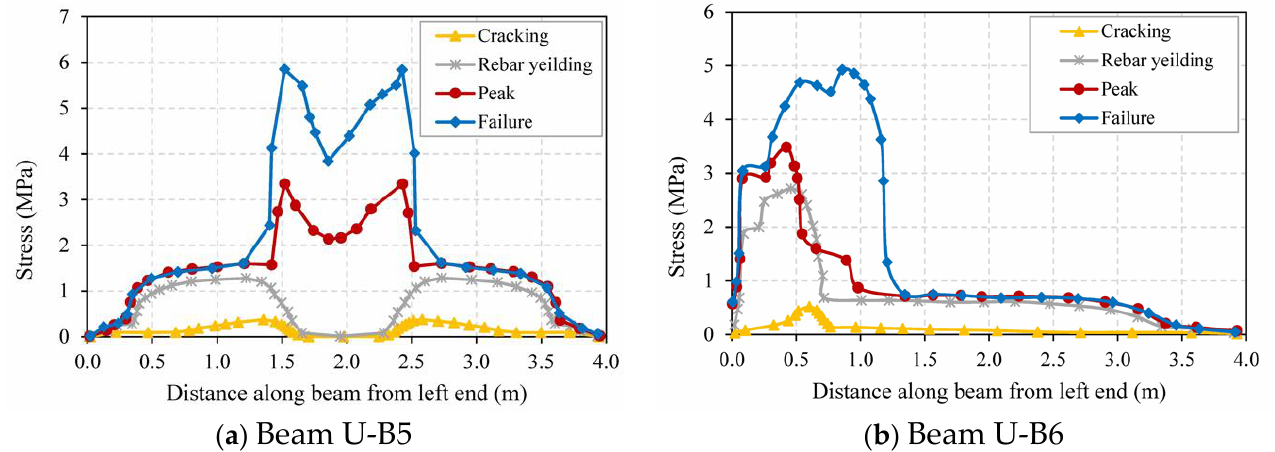
Figure 7. Level of bond stress developed in beams U-B5 and U-B6 along the beam length.